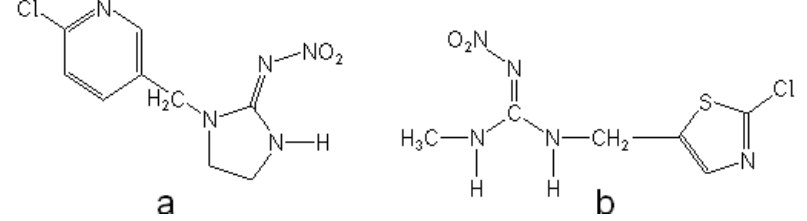
Figure 1. Selected members from two different generations of the neonicotinoid insecticides: imidacloprid ( a ) and clothianidin ( b